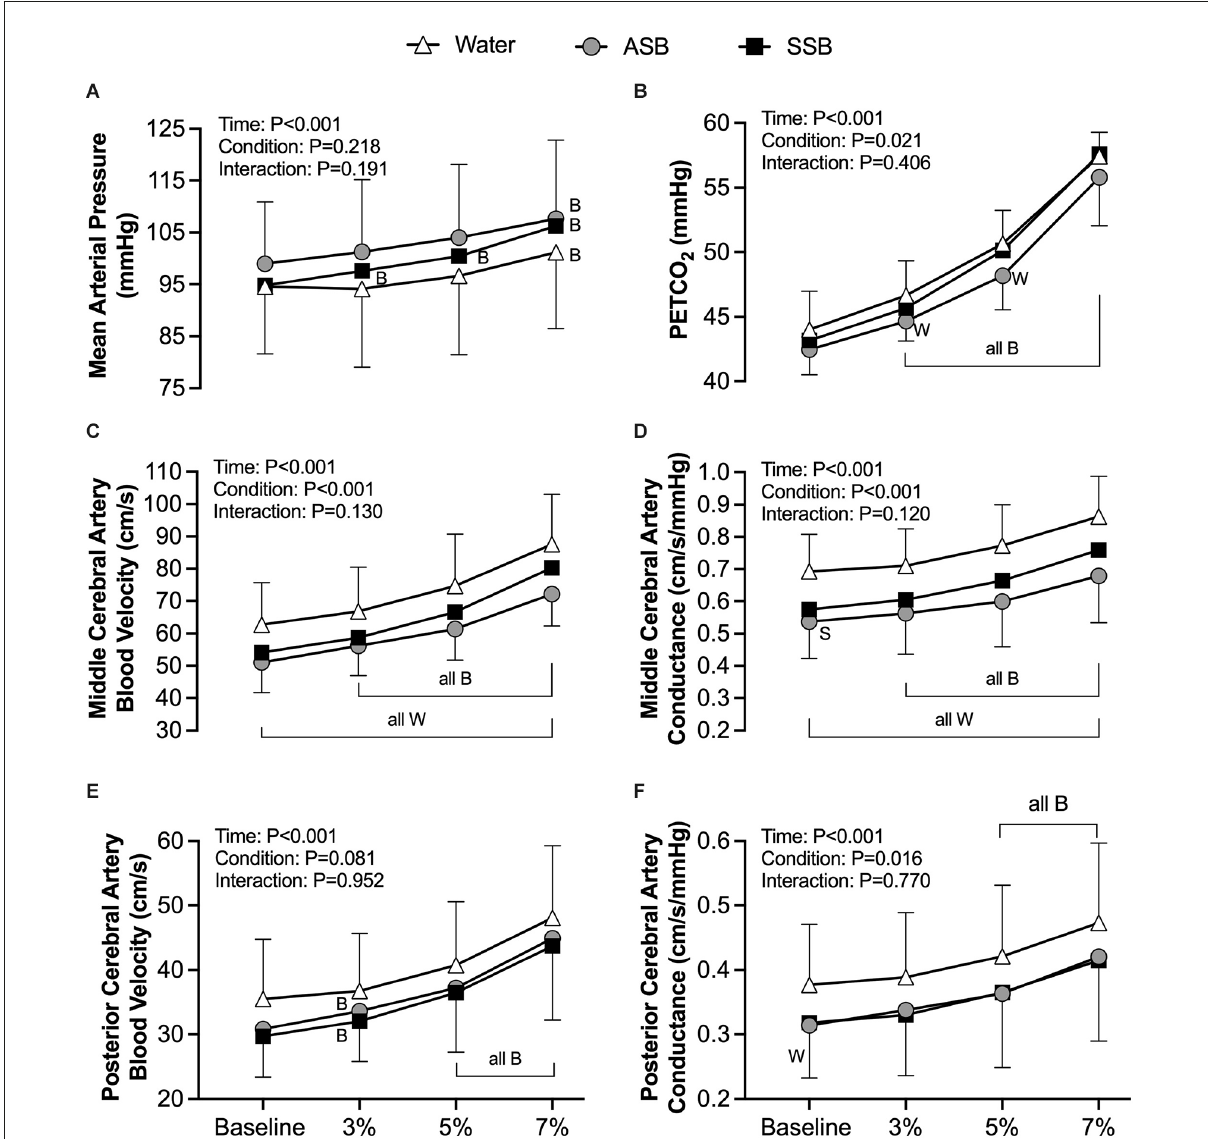
FIGURE6 Mean arterial pressure (A) , PETCO 2 (B) , middle cerebral artery blood velocity (C) , middle cerebral artery conductance (D) , posterior cerebral artery blood velocity ( E ; n = 10, three females for water, n = 11, n = 4 for ASB, and n = 10, two females for SSB), and posterior cerebral artery conductance ( F ; n = 10, three females for water, n = 11, four females for ASB, and n = 10, two females for SSB) obtained from each stage of the cerebral vascular reactivity to hypercapnia test. Mixed effects models were used to compare data between conditions. If a mixed effects model revealed a significant effect, a post-hoc Holm-Sidak multiple comparisons test was used to determine where differences existed. Data are presented as mean ± standard deviation. n = 12, four females unless otherwise noted. Missing data occurred due to the loss of signal and/or inability to obtain a quality signal while maintaining the same depth and/or gain with the transcranial Doppler signal. B Different from baseline ( P < 0.050); W Different from water ( P < 0.050); S Different between soft drinks ( p < 0.050); all B = all three beverages are different ( P <